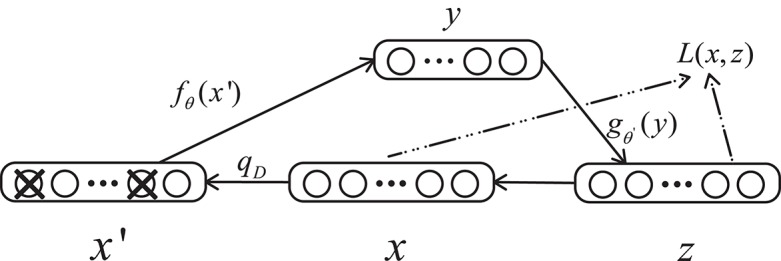
Structure of a denoising autoencoder. x represents the input data, x′ is the corrupted input, and L is the loss function.